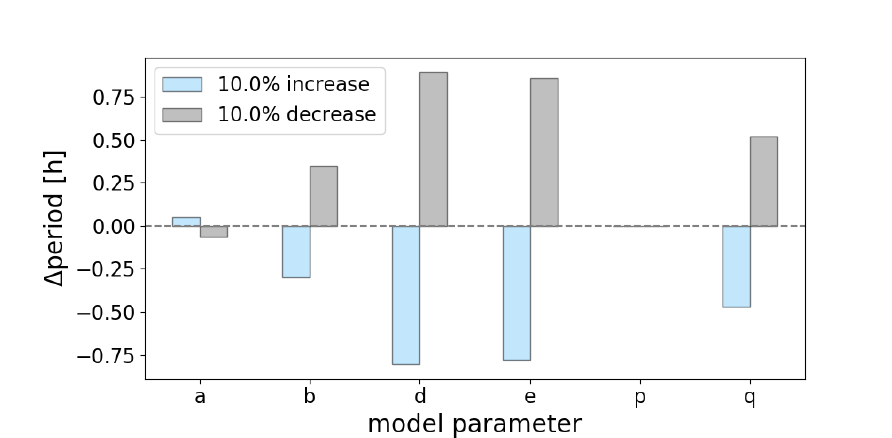
Figure A5. Period sensitivity analysis as a function of a 10% increase (blue) or 10% decrease (gray) of the default parameter value shown in the caption of Figure 4. ∆ period [h] represents the difference between the period calculated from the new parameter set and the period from the default parameter set. Period values are obtained for each parameter set by numerical integration of the model equations given in Figure